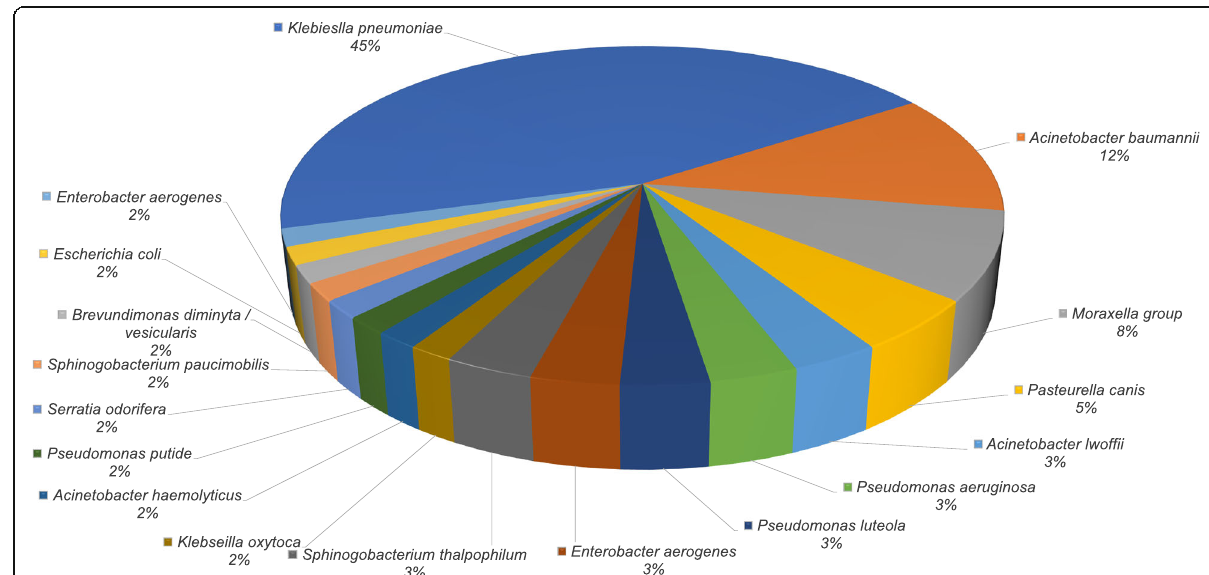
Fig. 1 Distribution of infectious agents in patients with ventilator-associated pneumonia in the ICU of BSU Hospital